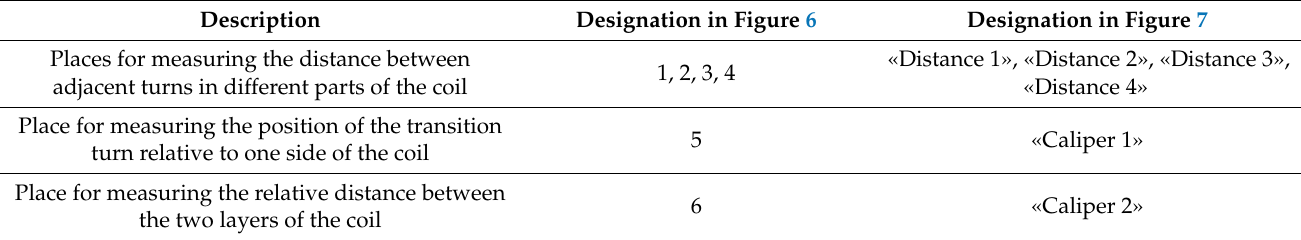
Table 2. Designation of measurement points in Figures 6 and